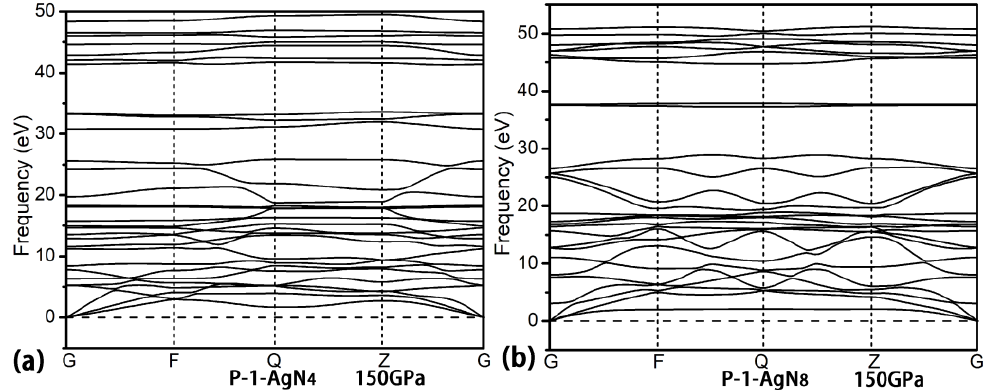
Figure 3. The phonon dispersion of P-1-AgN 4 at 150 GPa ( a ) and P-1-AgN 8 at 150 GPa ( b ).